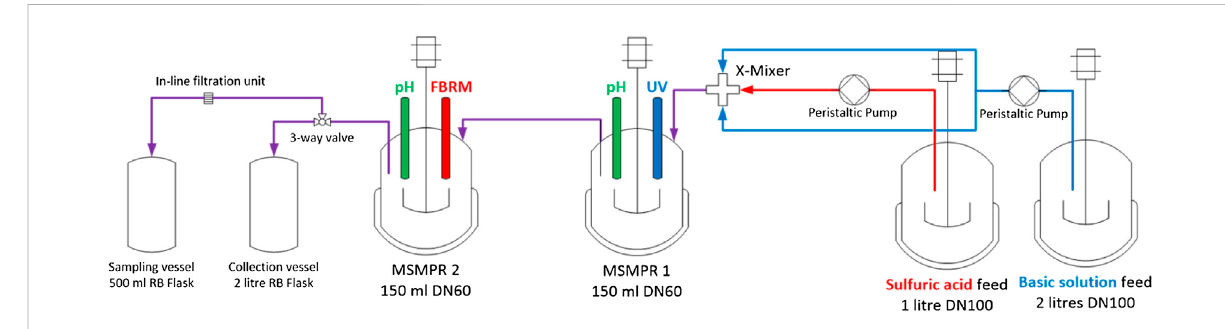
FIGURE 6 X-mixer and MSMPR cascade with dimensions indicated.